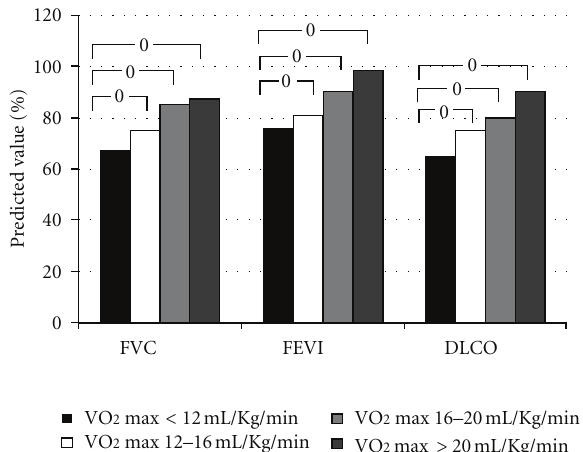
Figure 1: Lung function at rest in 190 heart failure patients in stable clinical condition. Patients were grouped according to exercise capacity. From left to right: peak VO 2 < 12 mL/min/kg (black bars), peak VO 2 = 12–16 mL/min/kg (white bars), peak VO 2 = 16–20 mL/min/kg (grey bars), and peak VO 2 > 20mL/min/kg (dashed bars). FVC: forced vital capacity; FEV1: forced expiratory volume 1 second; DLCO: lung di ff usion for carbon monoxide. Data from [8, Table